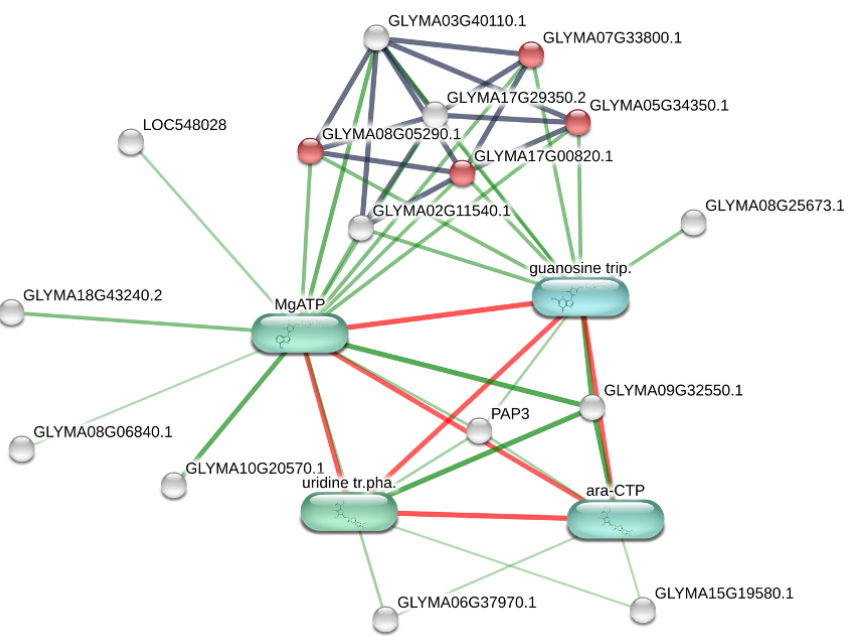
Figure 5. Biological network of differentially expressed proteins in response to herbicide application of GM soybean plants. The visual network was built using Stitch database. Additional metabolites (green) were added as functional partners in order to show network context. Stronger associations are represented by thicker lines. Protein–protein interactions are shown in grey, chemical–protein interactions in green and interactions between chemicals in red. Image is automatically retrieved from the Stitch software. No manual entries have been made.